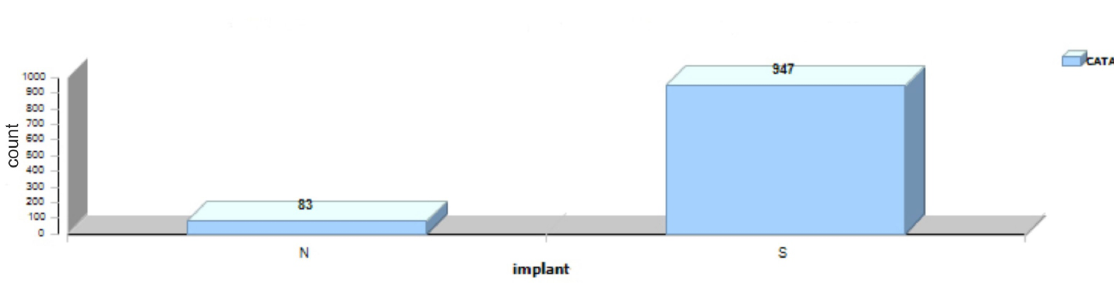
Figure 4: Number of implants in cataract